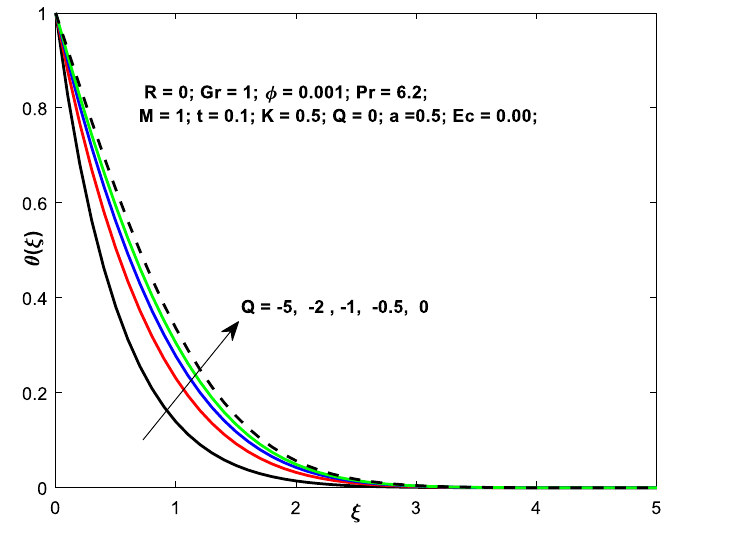
Figure 2. Q v/s θ when R = Q = Ec = 0 .